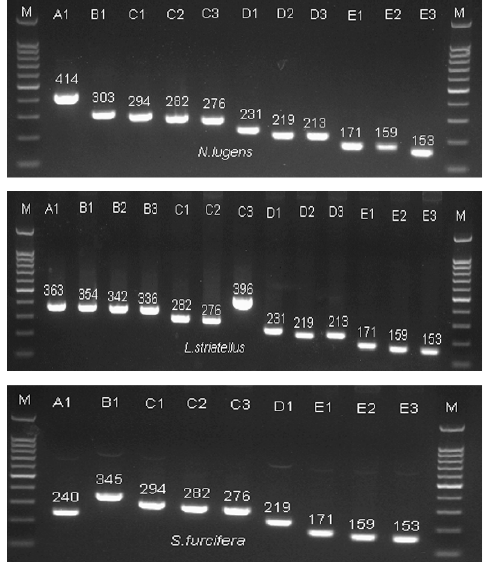
Figure 5. PCR products of the cloned cDNA sequences of CaMKII using 5’ and 3’ primers on either side of the nucleotide insertion site. M: DNA marker; A1–E3: the isoforms of CaMKII A1–E3; and Arabic numerals indicate the amplicon size.